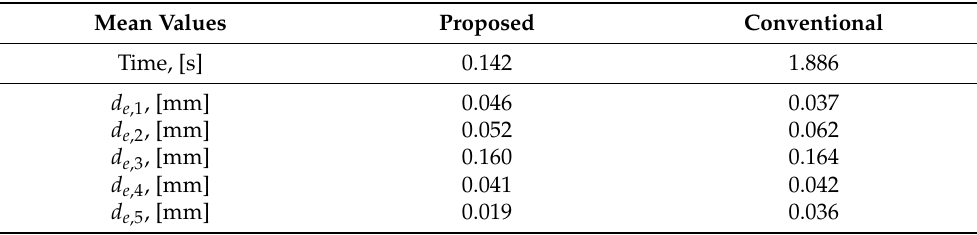
Table 5. Comparison of the results using dataset 5. The fit error definition is given in the beginning of Section